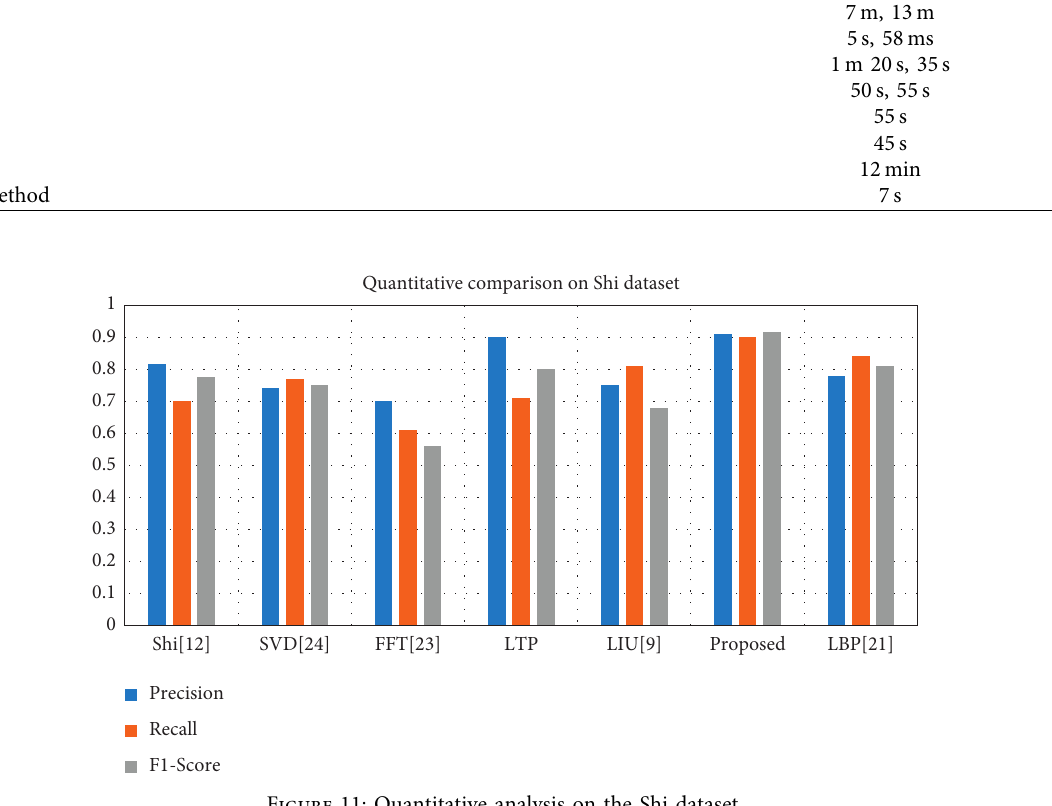
Figure 10: Comparison of local pattern-based approaches. Table 2: Computational cost comparison of the proposed method against state-of-the-art methods. DBD methods